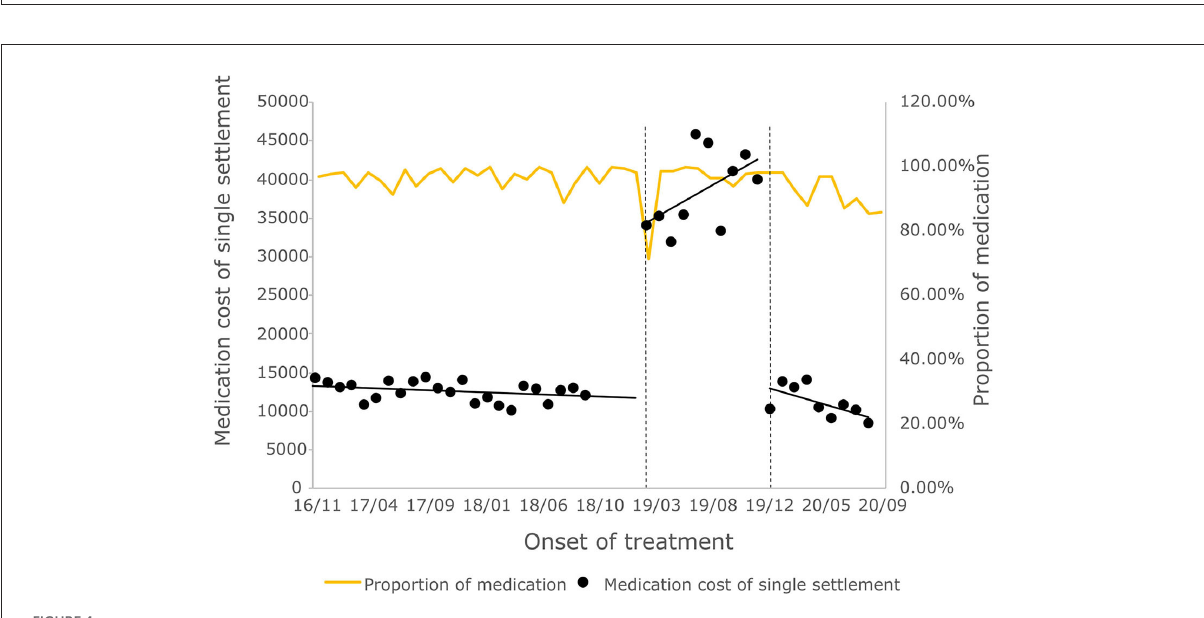
FIGURE3 Cost of single settlement for hepatitis C patients.